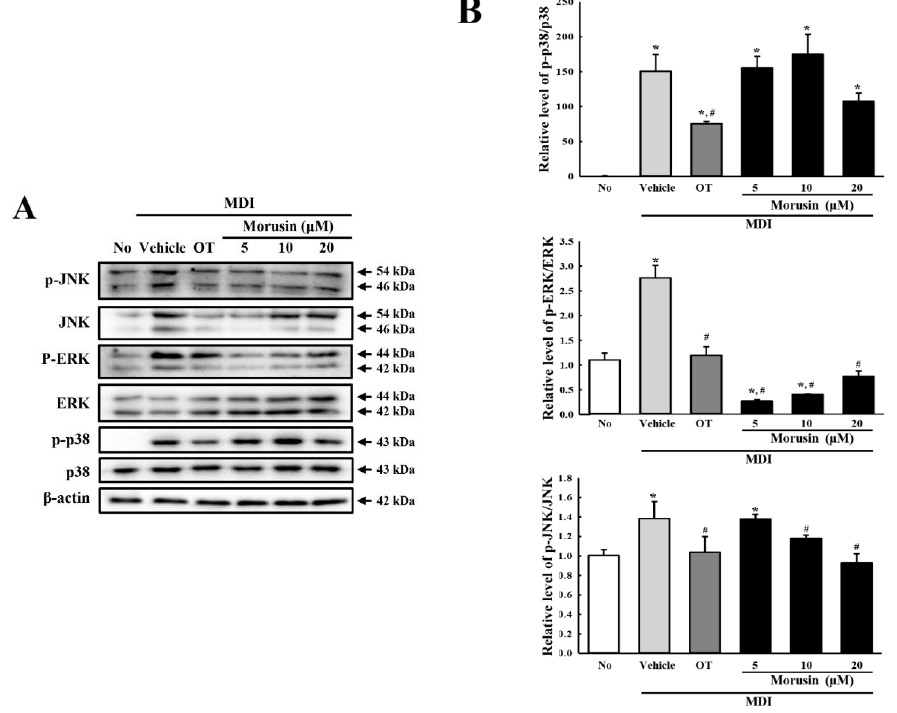
Figure 3. Expression analysis of three members of the MAPK signaling pathway. ( A ) After the incubation of 3T3-L1 adipocytes in MDI + morusin, the expression levels of JNK, ERK, p38 and β -actin were detected with specific antibodies, followed by horseradish peroxidase-conjugated goat anti-rabbit IgG. ( B ) Band intensities were measured by using an imaging densitometer, and the levels of each protein were calculated relative to the intensity of the actin bands. The data represents the means ± SD of three replicates. * indicates p < 0.05 compared to the untreated group. # indicates p < 0.05 compared to the MDI+vehicle-treated group. OT; orlistat, MDI; adipogenic cocktail consisting of 3-isobutyl-1-methylxanthine, dexamethasone, and insulin.